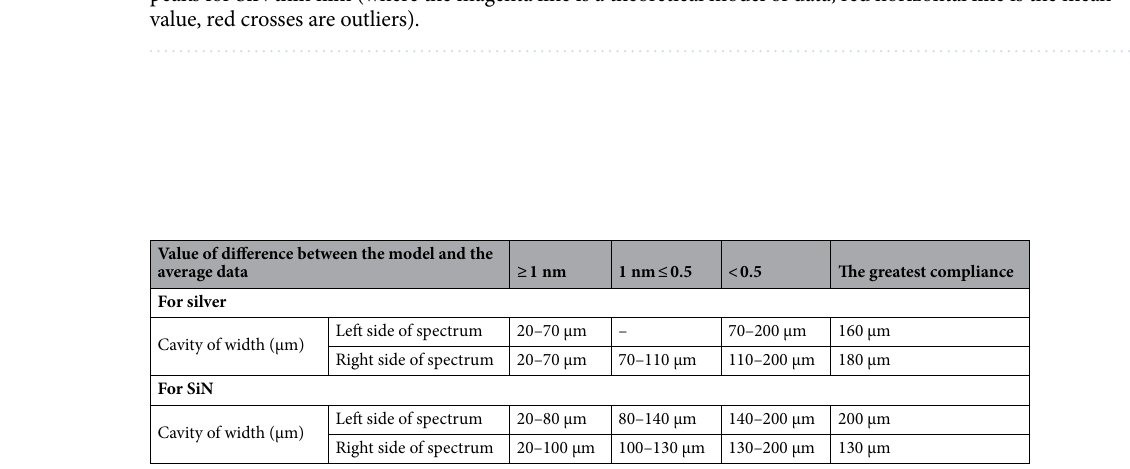
Table 3. Comparison between the theoretical model and the average data of 1550 nm.